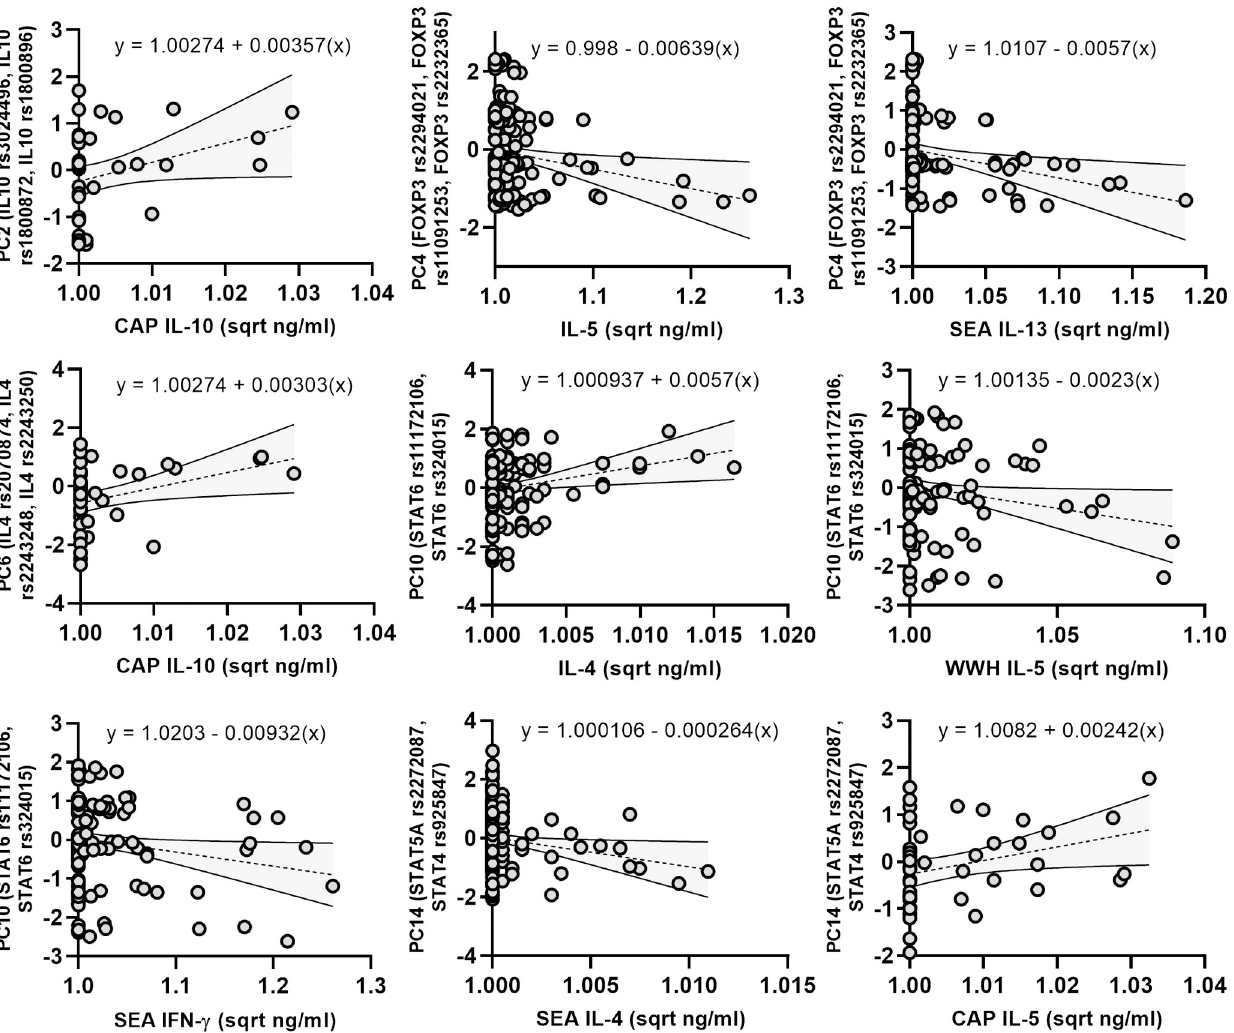
Fig 5. Regression scatterplots of systemic and parasite-specific cytokines against PC scores. X axes show square-root (x+1) transformed values. Dashed line shows regression best line of fit, and shaded area shows 95% confidence intervals of the best line of fit. Regression analysis found significant relationships between systemic and parasite-specific cytokine levels and PC2 (CAP-specific IL-10), PC4 (systemic IL-5, SEA-specific IL-13), PC6 (CAP- specific IL-10), PC10 (systemic IL-4, WWH-specific IL-5, SEA-specific IFN γ ) and PC14 (SEA-specific IL-4, CAP-specific IL-5). PC = principal component; CAP = cercariae antigen preparation; SEA = soluble egg antigen; WWH = whole worm homogenate.